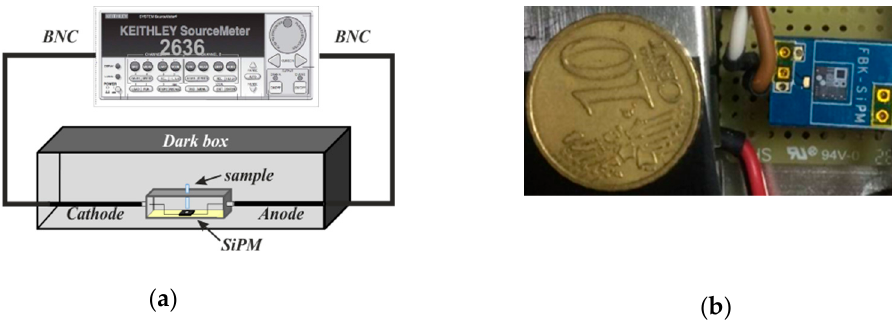
Figure 2 . ( a ) Scheme of the optical sensing system for bioluminescence analysis of the integrated Hg reporter cells. ( b ) Detail of the silicon photomultiplier (SiPM) sensor (the 250 µm × 250 µm SiPM structure is included in a bigger test chip, mounted on Fondazione Bruno Kessler (FBK) custom PCB/package).